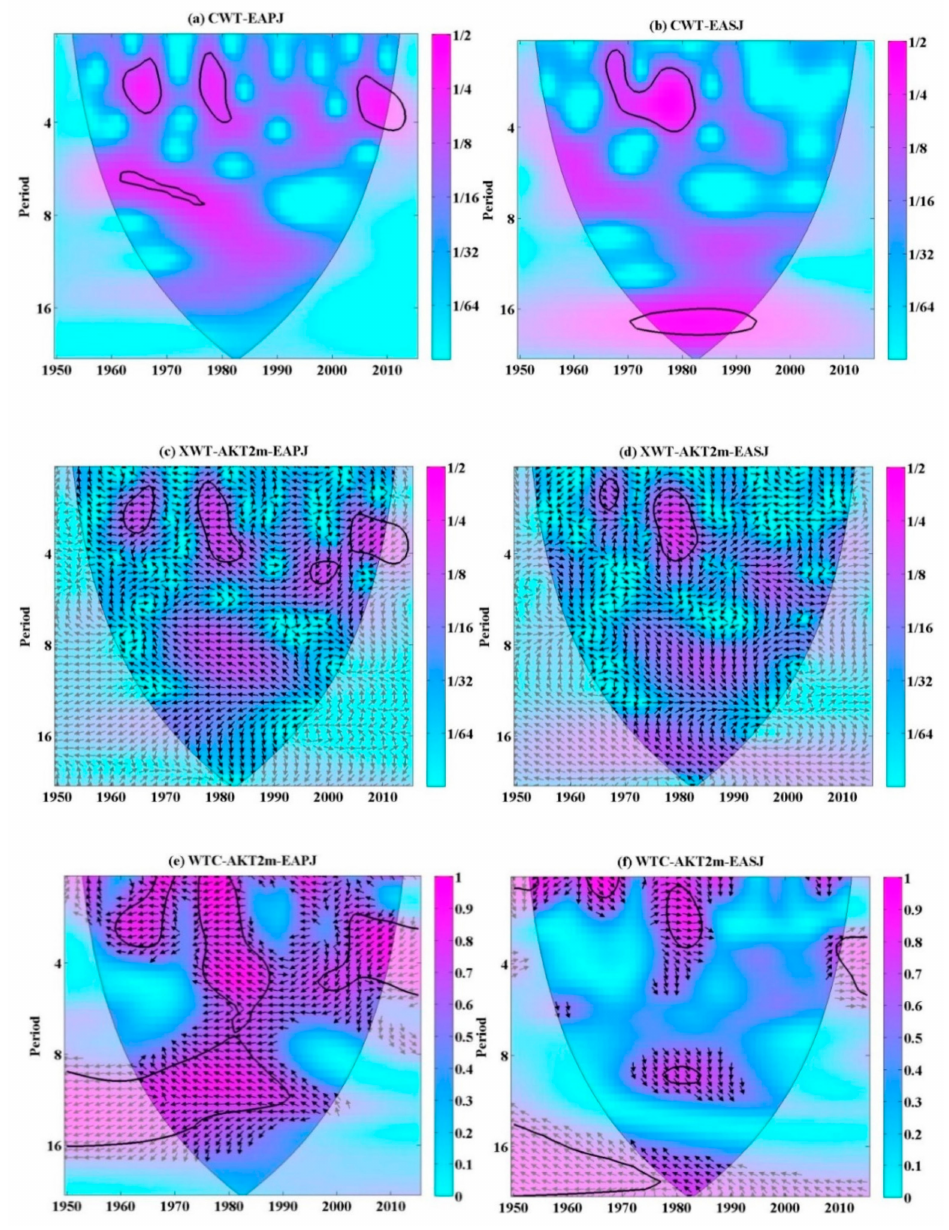
Figure 4. Continuous wavelet power spectra (CWT) for the standardized time series of the ( a ) EAPJ and ( b ) EASJ, the cross-wavelet transform (XWT) of the ( c ) AKT2m and EAPJ and ( d ) AKT2m and EASJ, and the squared wavelet coherence (WTC) of the ( e ) AKT2m and EAPJ and ( f ) AKT2m and EASJ during the winters of 1950–2016. The thick black contour shows the 5% significance level against red noise, and the thin black line indicates the cone of influence where edge e ff ects might distort the picture shown in a lighter